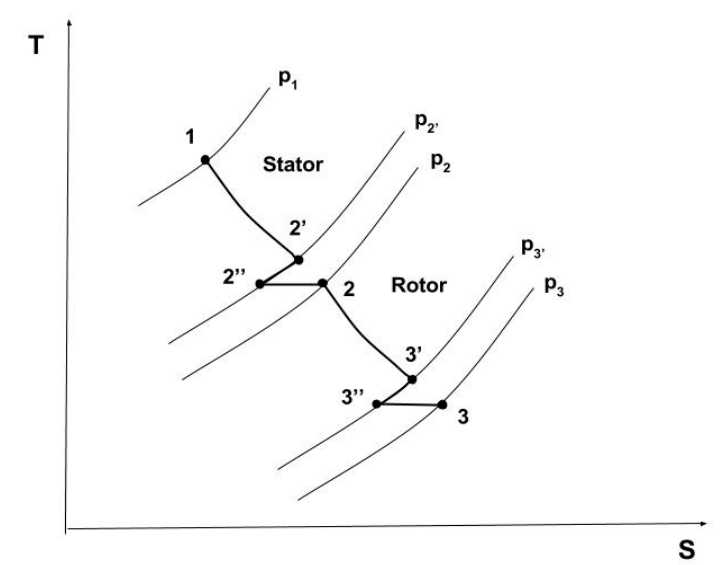
Figure 2. The proposed cooled expansion.